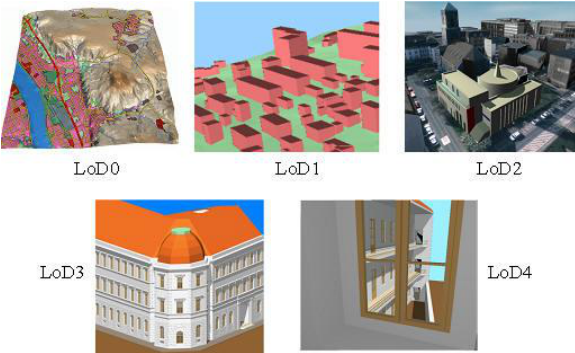
Figure 1. The LoDs concept in CityGML v2.0 standard (Kolbe and Bacharach, 2006).